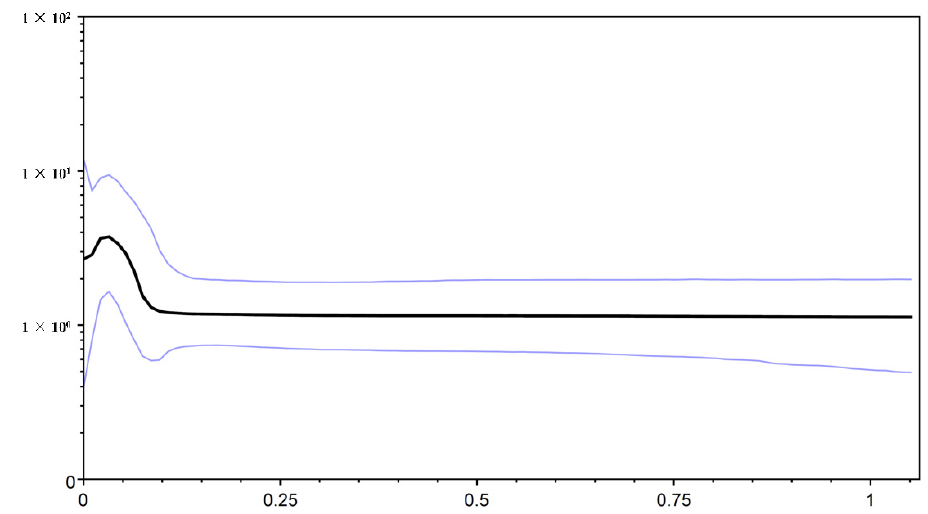
Figure 5. Bayesian skyline plots for the cyt b + D-loop of O. hainanensis from mainland China and Hainan Island. The x -axis gives units in millions of years before the present, and the y -axis is effective population size (Nes) and on a log scale. The solid line indicates the median estimate, whereas the thinner lines indicate the 95% credibility intervals.